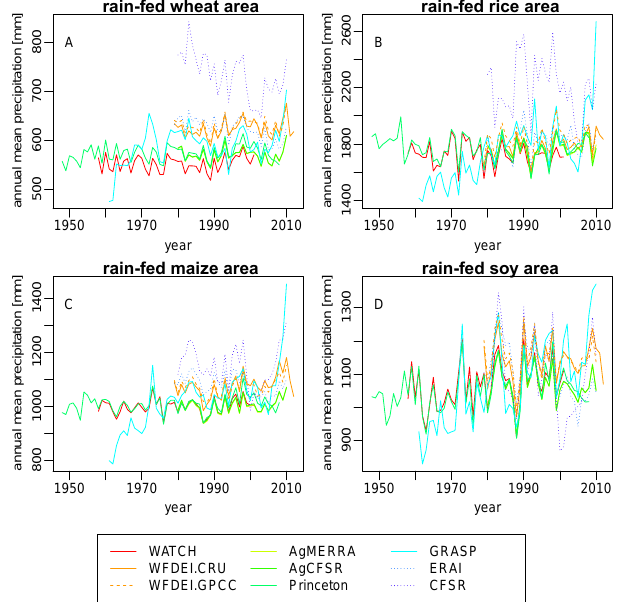
Figure 2. Area-weighted mean of annual precipitation [ ◦ C] for cropping areas for rain-fed wheat (a) , rice (b) , maize (c) , and soy (d)